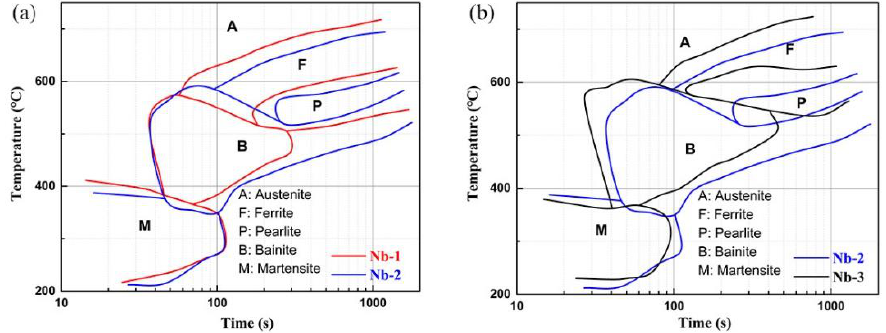
Figure 5. Comparison of different phase transformation intervals ( a ) Nb-1–Nb-2 ( b )